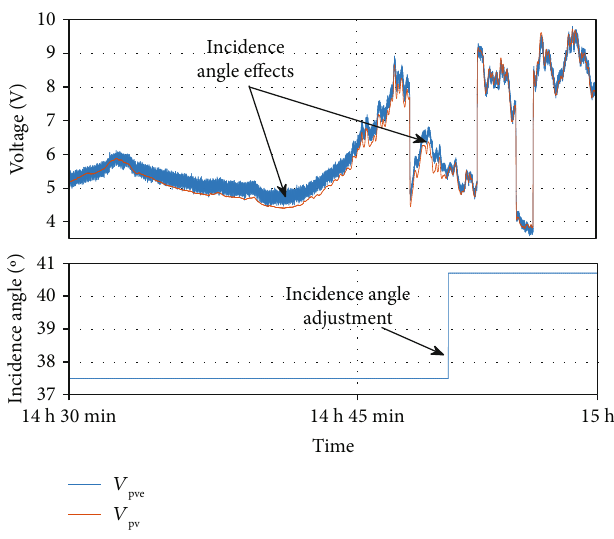
Figure 17: Incidence angle e ff ect on emulator output.